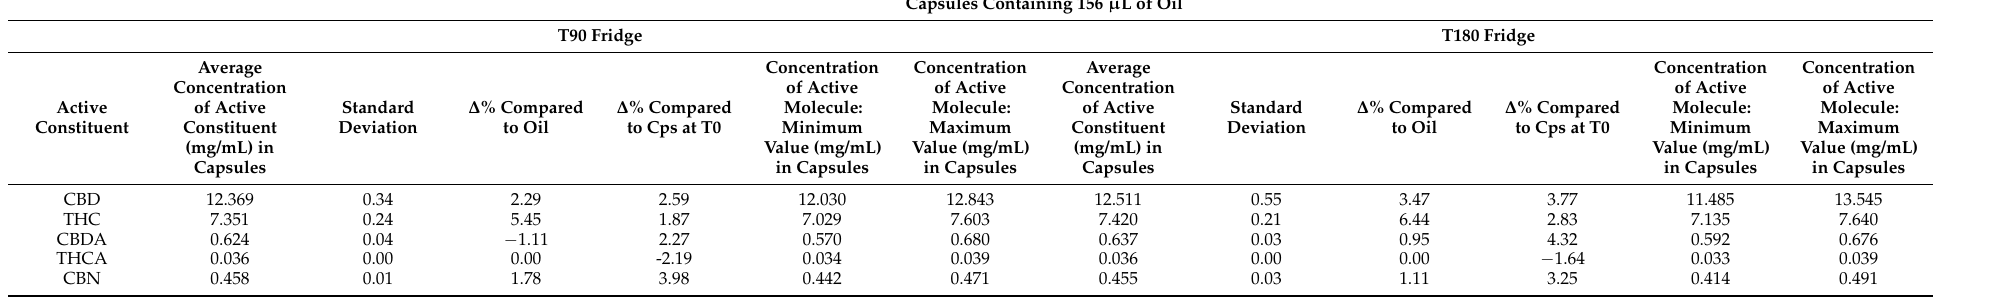
Table 3. Capsule